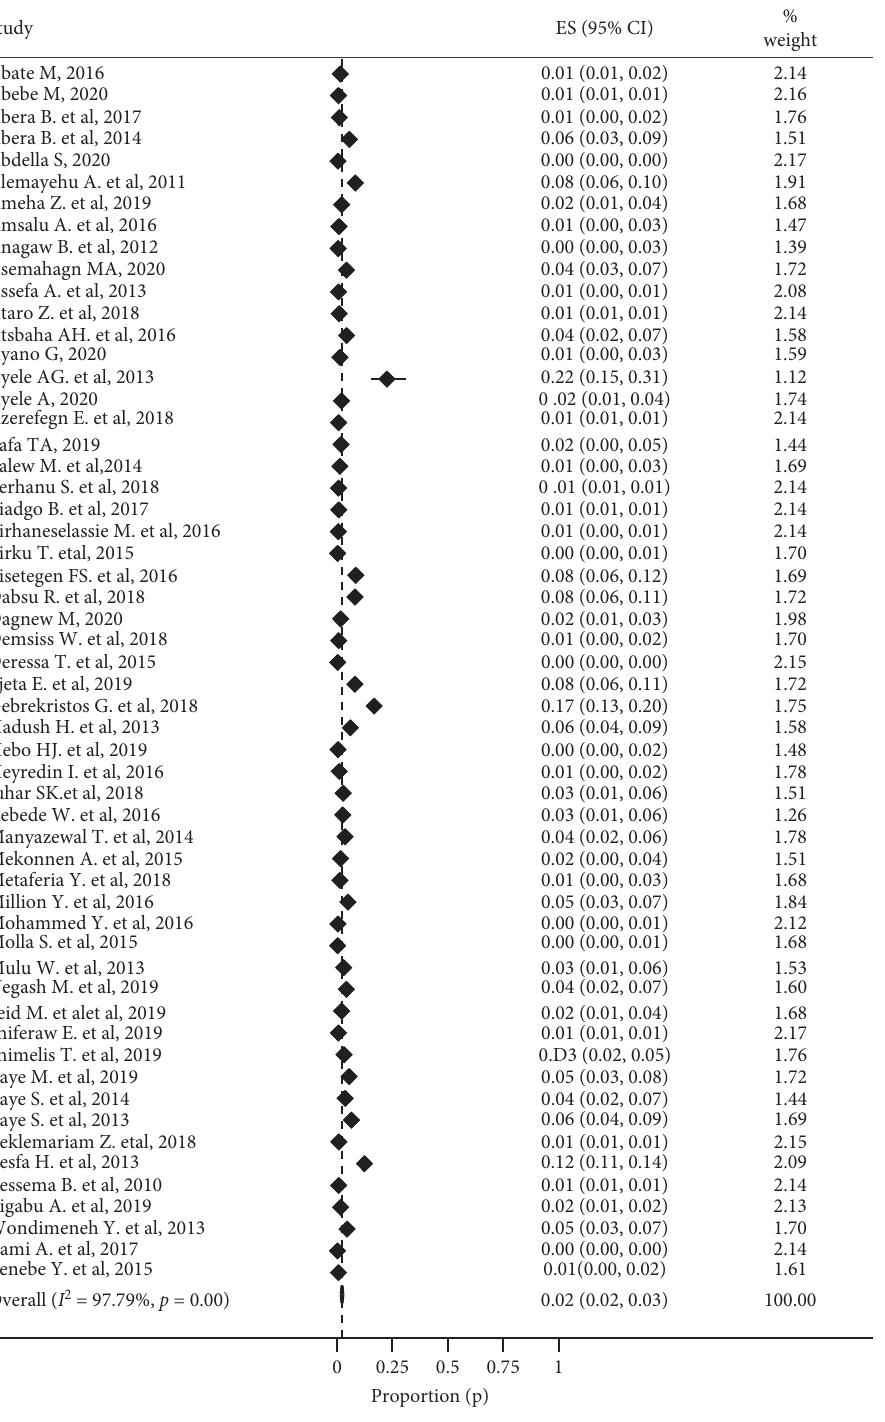
Figure 2: Poole prevalence of anti-HCV in Ethiopia from 2010 to